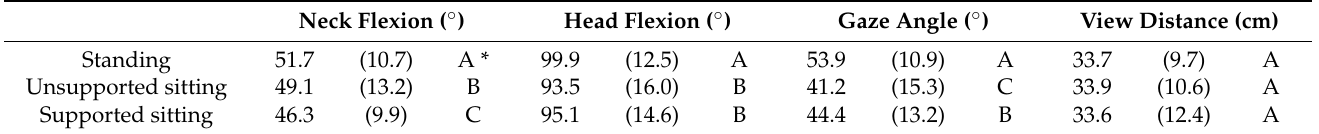
Table 4. Duncan grouping results for varying operating